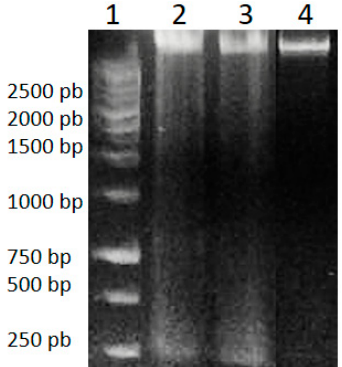
Figure 2. DNA Ladder ( 1 ), genomic DNA of HeLa cells treated with A. cornutum extract ( 2 ), genomic DNA of HeLa cells treated with A. cepa extract ( 3 ), genomic DNA of untreated HeLa cells ( 4 ).